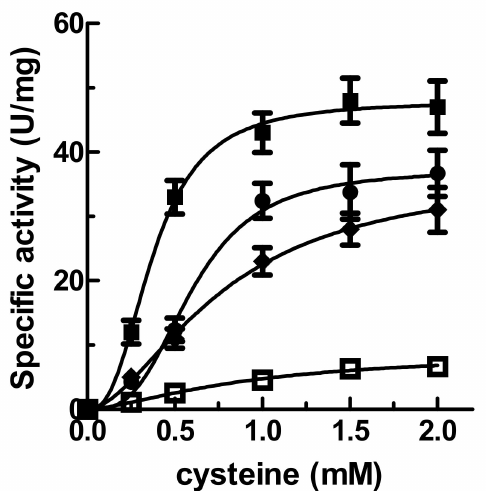
Figure 1. Kinetic assays of AtNFS1:AtISD11:AtFH. L-Ala production from cysteine catalyzed by AtNFS1 in the presence of AtISD11 (1:1, circles); AtFH (1:1, diamonds); AtISD11 and AtFH (1:1:1, black squares) or AtNFS1 alone (empty squares). One unit of activity is defined as the amount of enzyme catalyzing the production of 1 µ mol of L-alanine per min. at 37 ◦